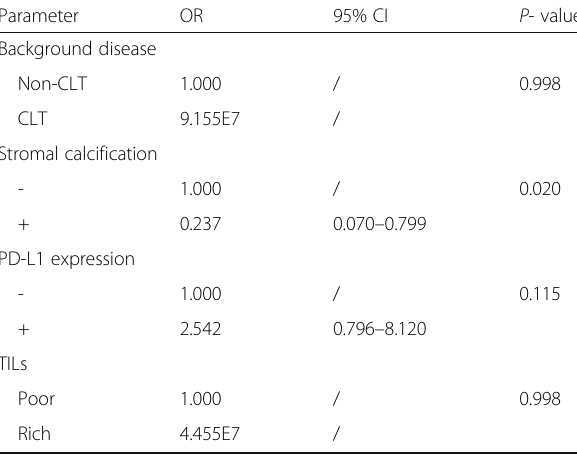
Table 5 Multivariate logistic analysis of examined clinicopathological parameters influencing PD-1